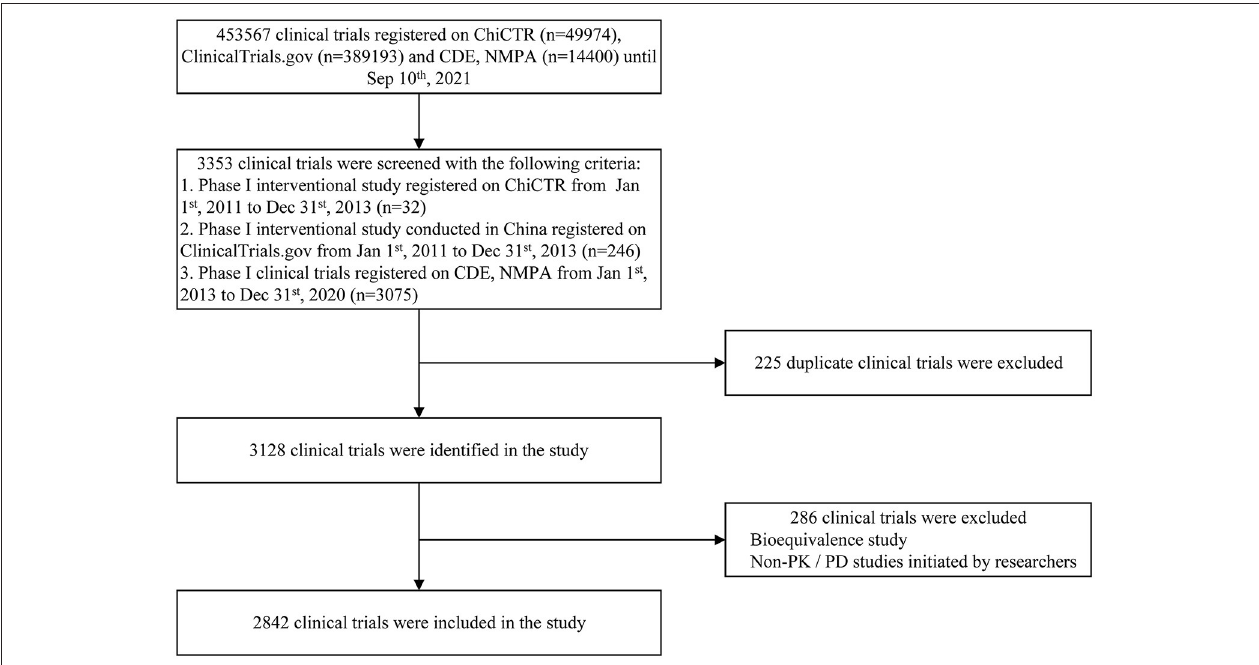
FIGURE 1 | Flow diagram of the phase I clinical trial selection